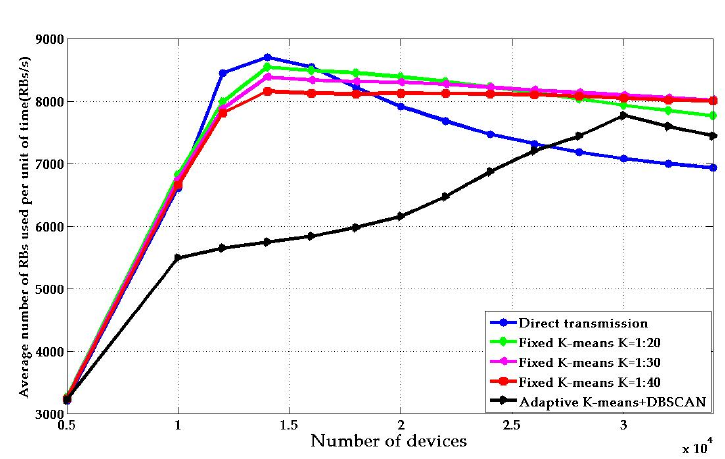
Figure 5. Average number of Resource Block (RB)s used per unit of time.